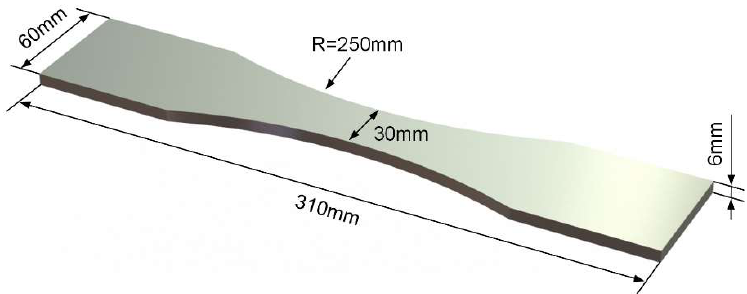
Figure 1. Schematic diagram of specimen for fatigue tests.